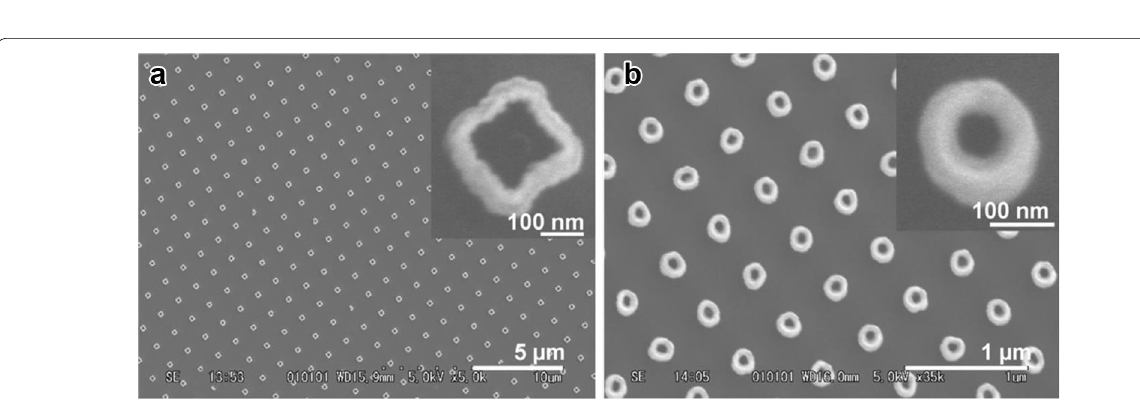
160 nm inner squares and b Au hollow pillar arrays with ∼